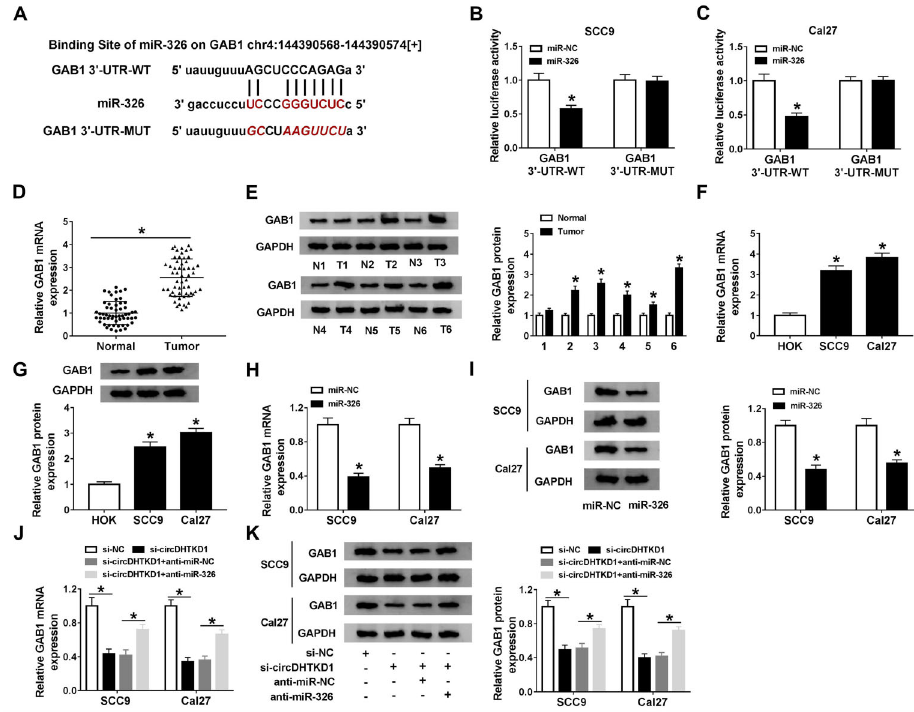
Figure 5. circDHTKD1 regulated GAB1 expression via interacting with miR-326. A , starBase was adopted to predict the binging region between miR-326 and GAB1 3 0 -UTR. B and C , Dual-luciferase reporter assay was used to determine whether miR-326 could combine with GAB1 3 0 -UTR in SCC9 and Cal27 cells. GAB1 mRNA and protein levels in OSCC tissues ( D and E ) and cells ( F and G ) were detected with qRT-PCR and western blot. qRT-PCR and western blot were used for assaying the mRNA and protein expression of GAB1 after transfection of miR-NC/miR-326 ( H and I ) and si-circDHTKD1, si-circDHTKD1 + anti-miR-326, or the relative control groups ( J and K ). Three biological and three technical replicates were performed in each assay. Data are reported as means ± SD. *P o 0.05 (Student ’ s t -test and one-way ANOVA followed by Tukey ’ s